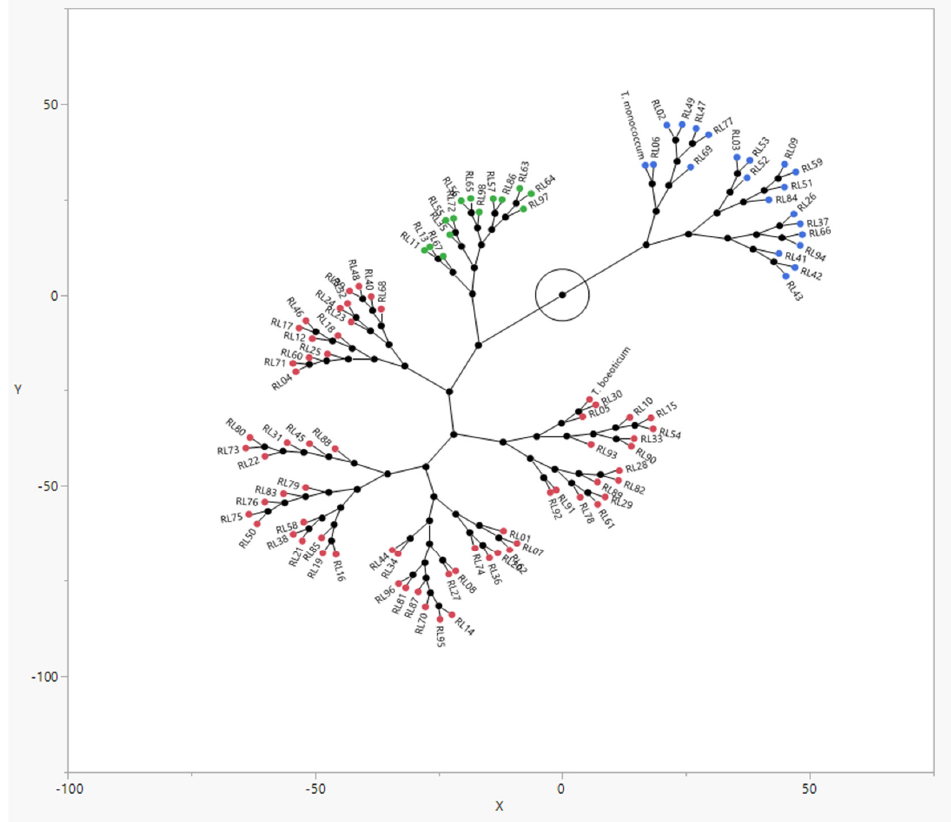
Figure 7. Constellation plot of the dendrogram generated via agglomerative hierarchical clustering (AHC) cataloging parental and RILs genotypes in discrete clusters. Clusters I, II, and III represent red, green, and blue points, respectively. Data for twelve phenotypic traits were appended to 100 parental genotypes and RILs correlation coefficients, and jointly submitted to principal component analysis followed by hierarchical clustering of the first three principal components. The corresponding dendrogram is illustrated in the form of a constellation plot in dimensionless units. The plot was constructed in JMP v 16 (SAS Institute Inc., Cary, NC, USA) using Ward’s minimum variance hierarchical clustering method on standardized data.